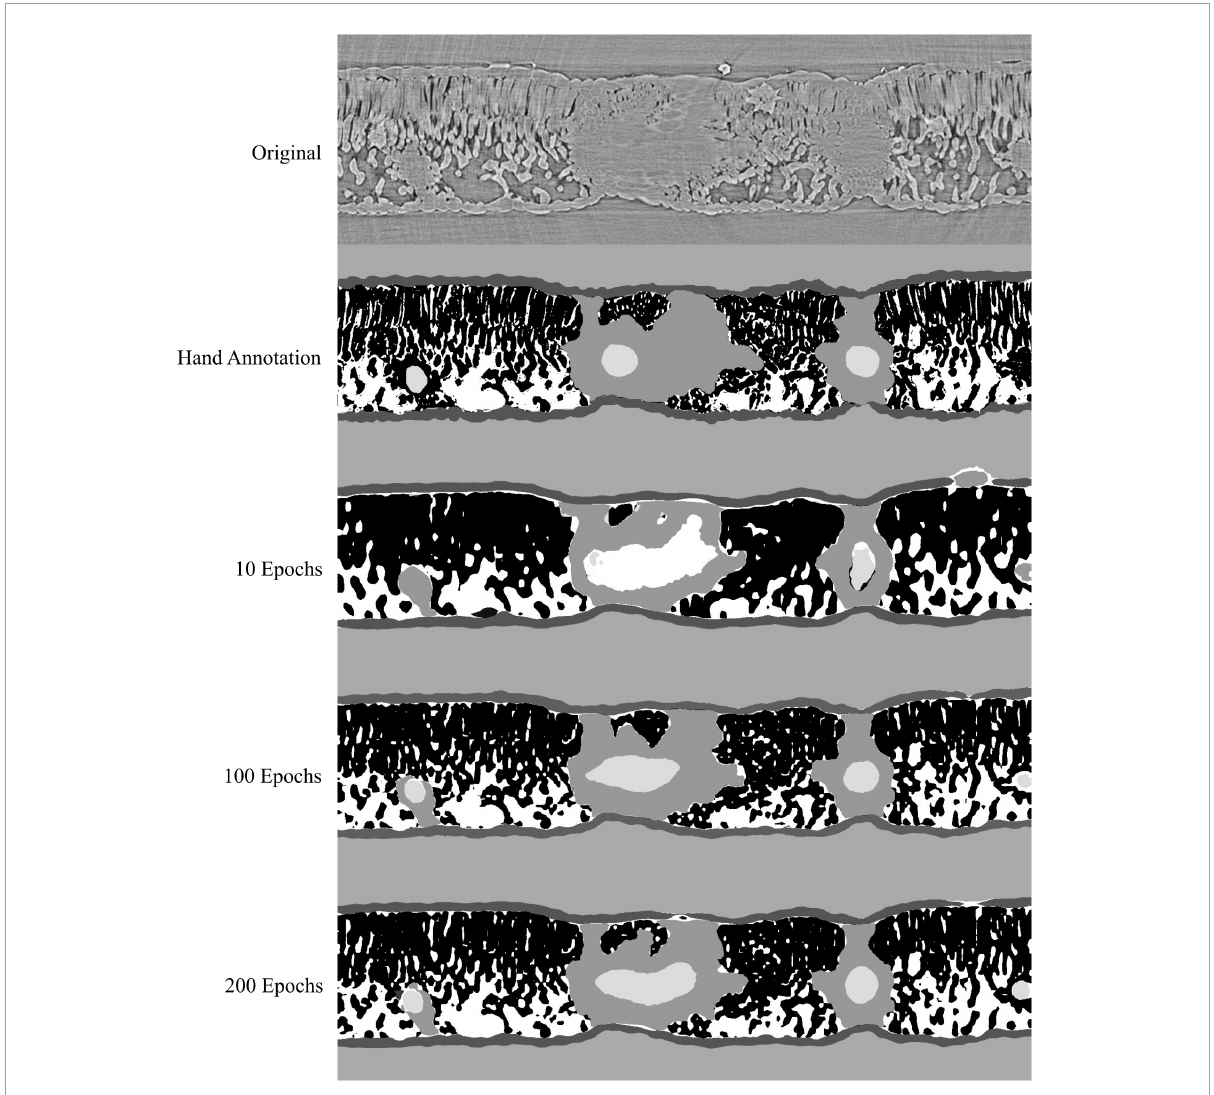
FIGURE5 Visual representation of the model outputs for a single walnut leaf image cross-section; top image is a X-ray CT scan taken from a leaf that was not used for training or validation of the applied models; next is the hand annotated image of the scan followed by the outputs from the best performing model trained for 10, 100, and 200 epochs, respectively. For the walnut leaf segmentation, the background is light gray, the epidermis is dark gray, the mesophyll is black, the air space is white, the bundle sheath extensions are middle gray, and the veins are lightest gray.